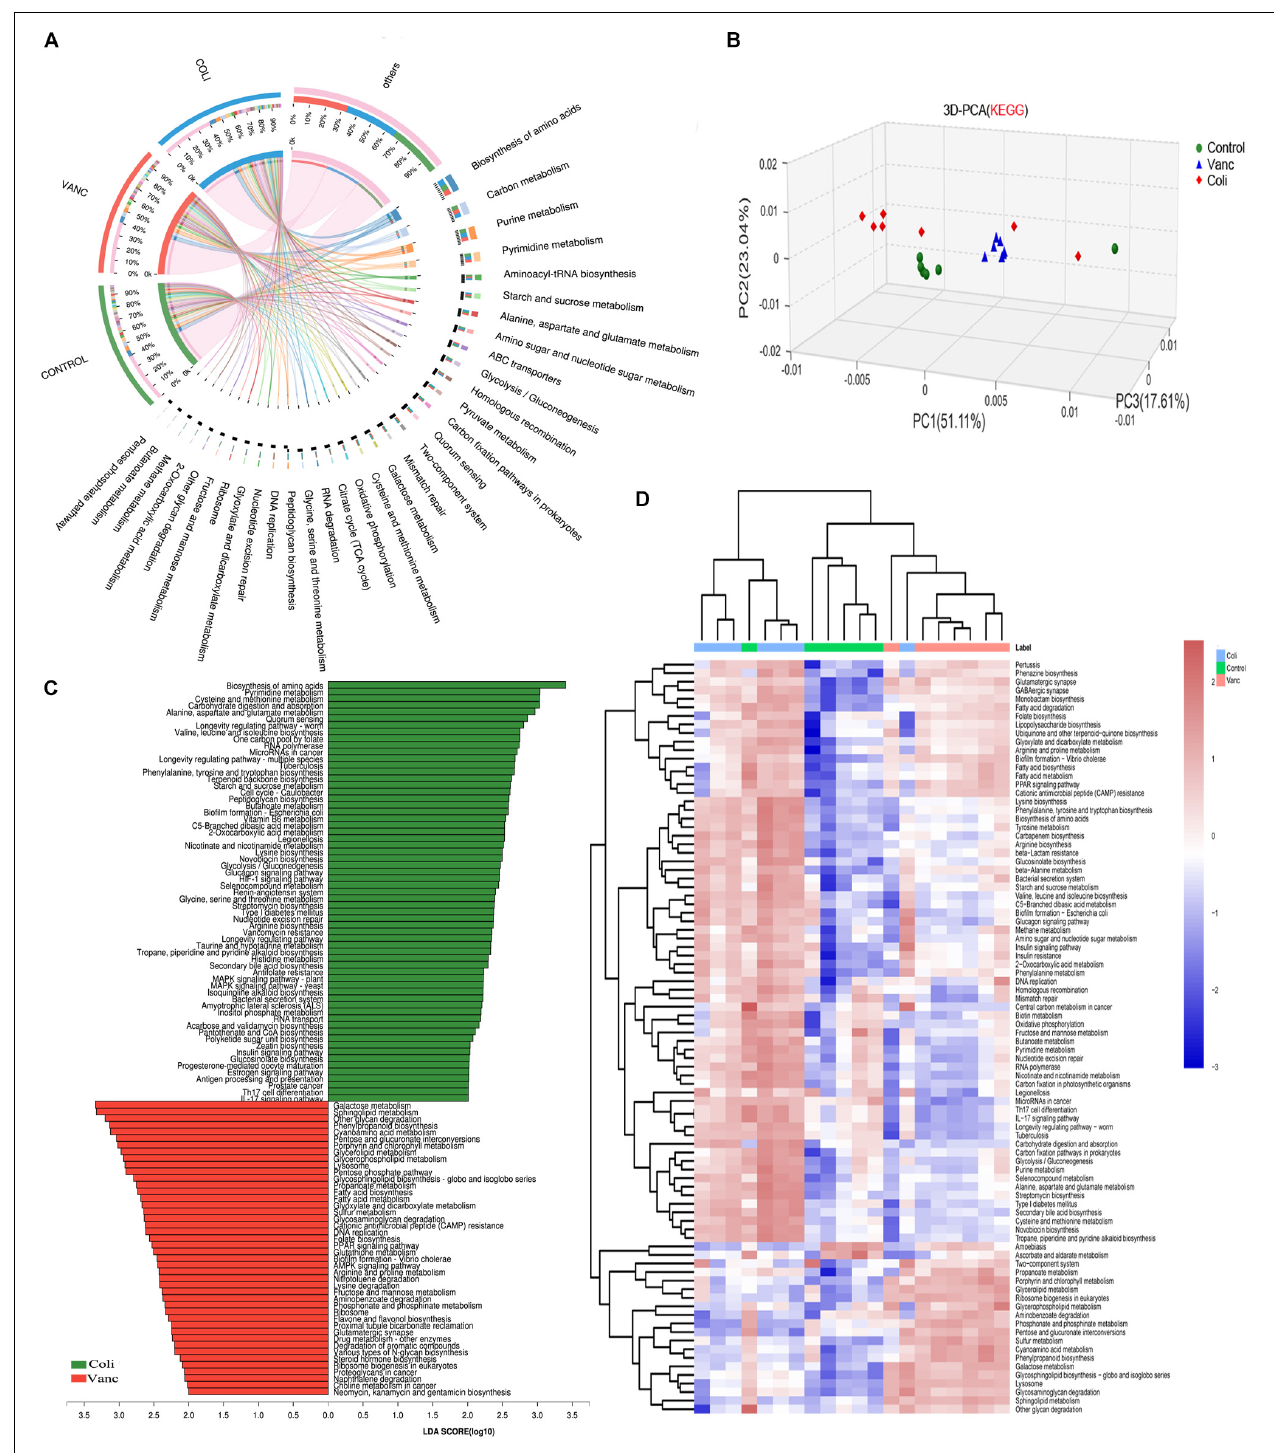
FIGURE 3 | Metagenomic analysis of functional diversity of gut microbiota. (A) Circos of samples and functional KEGG pathways. (B) 3D-PCA for KEGG pathways. (C) LDA scores computed for differentially abundant taxa in the fecal microbiomes of Coli group and Vanc group. Length indicates effect size associated with a taxon. p = 0.05 for the Kruskal–Wallis test; LDA score > 3. (D) Unsupervised hierarchical clustering of KEGG pathways predicted in the metagenomes of fecal samples. Columns represent samples and rows represent enrichment of predicted KEGG